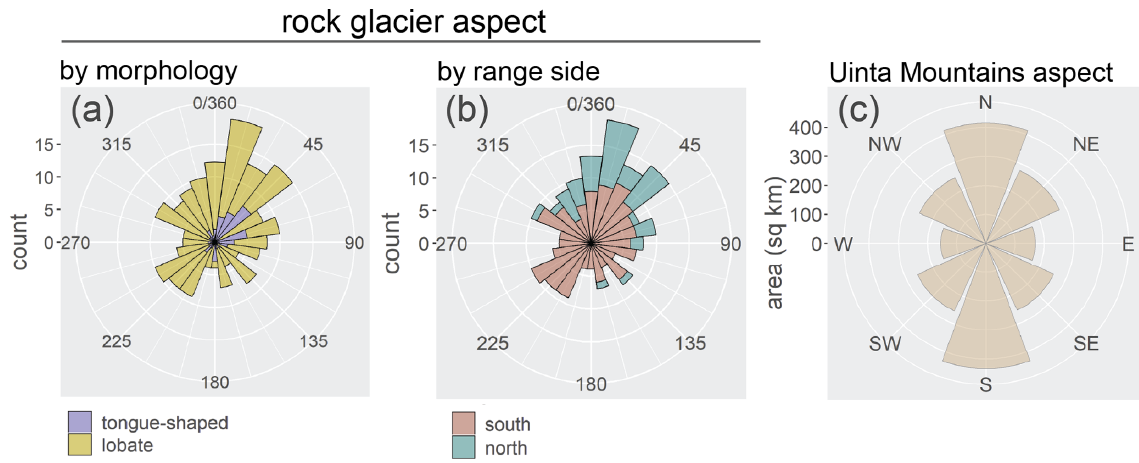
Figure 5. Polar plots showing aspect of active rock glaciers from the Uinta Mountains inventory and aspect of the steep slopes ( > 10 ◦ ) of the Uinta Mountains. (a) Aspect is classified by rock glacier morphology. (b) Aspect is classified by which side of the Uinta Mountains the rock glacier is on. (c) Aspect of steep slopes ( > 10 ◦ ) of the Uinta Mountains, for reference. Data are derived from rock glacier inventory polygons and a USGS